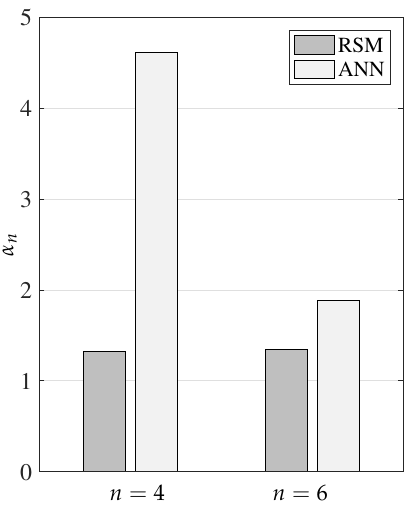
Figure 3. The values of α 4 and α 6 of the surrogate models computed from the RSM and ANN. The prediction values for the lift-to-drag ratio using RSM-computed and ANN-computed surrogate models for the 50 test samples are plotted in Figure 4 with their exact (computed from XFOIL) values. The prediction values presented in the left column are computed from the RSM-computed surrogate models with G-DLB-4-3, G-DLB-8-3, and O-DLB-6-4 from the top to bottom rows, respectively. The prediction values presented in the right column are identical to the ones plotted in the left column, but these values are from the ANN-computed surrogate models. The dashed line in which the